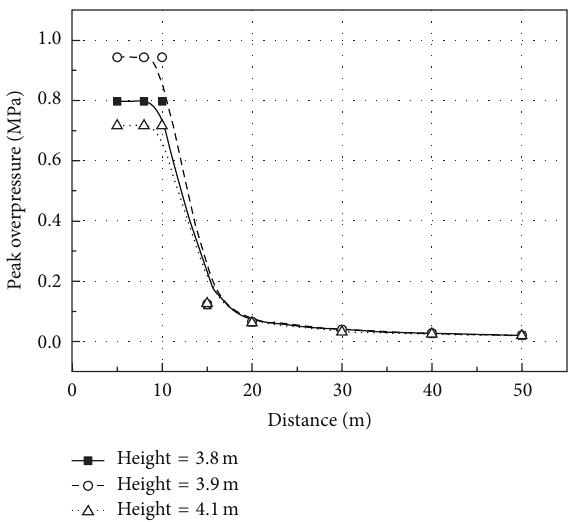
Figure 6: Comparison of overpressure under various heights versus different